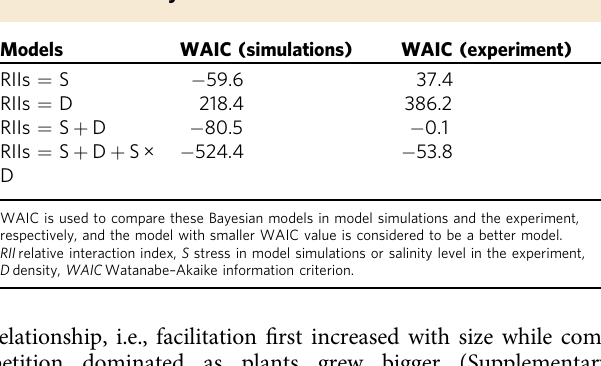
Table 1 Bayesian models relating plant – plant interactions to stress and density.